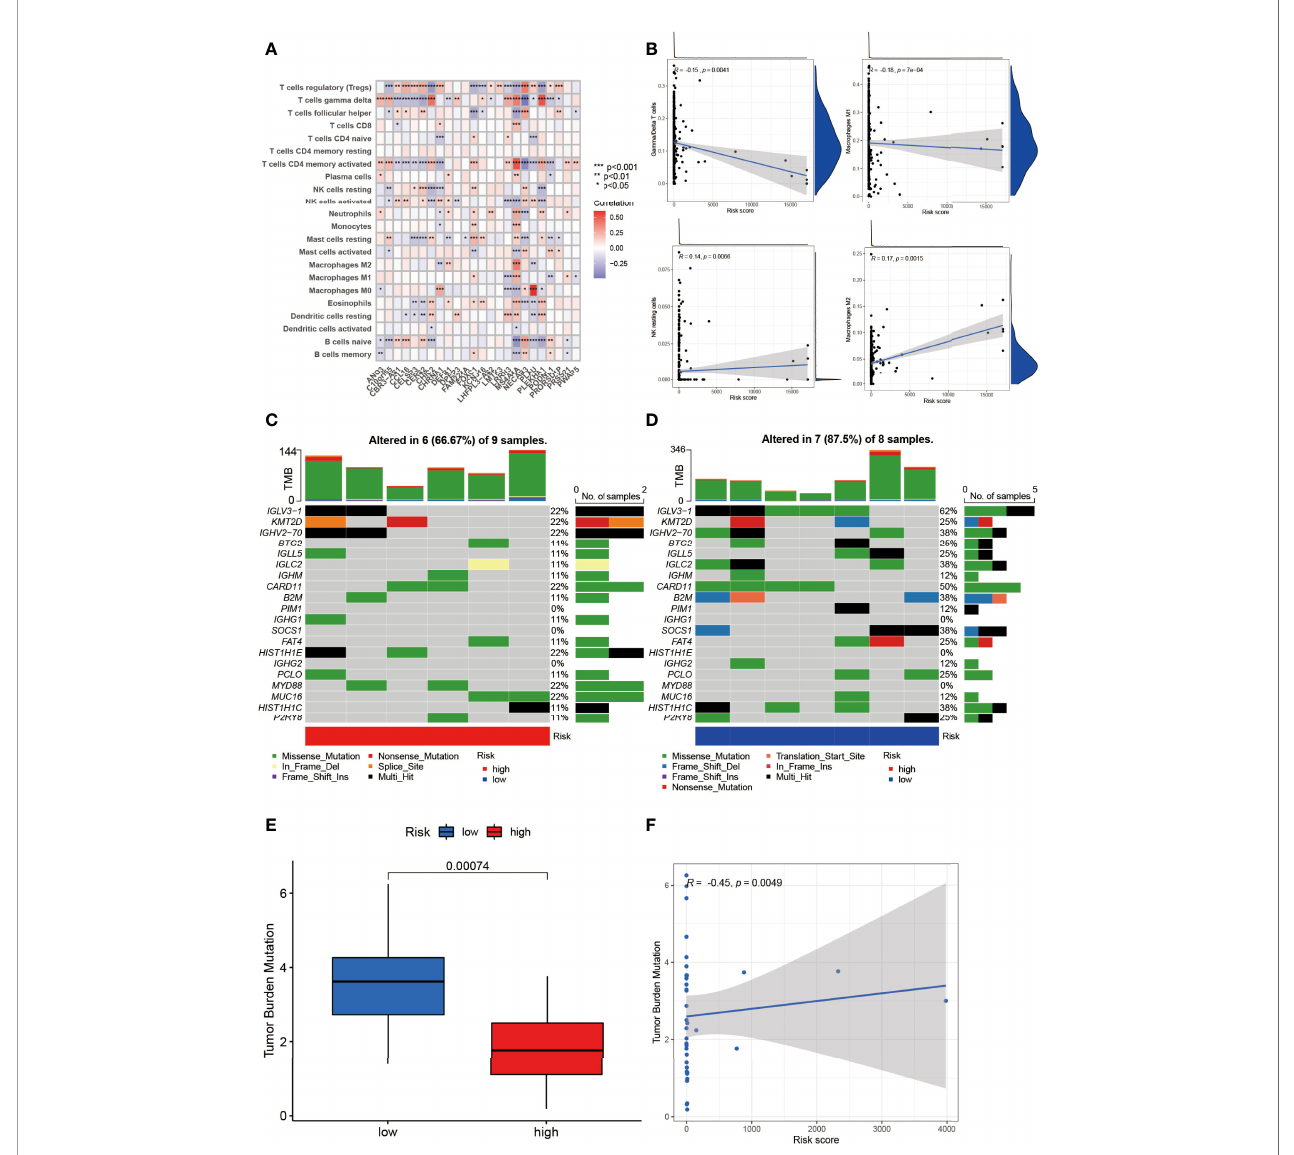
FIGURE 7 | Identi fi cation of immune in fi ltration and genetic variants underlying the different risk groups. (A) The correlation intensity between DEGs and immune cells. (B) The relationship of immune cells in risk score. g / d T cell and Macrophage 1 were negatively correlated with risk score while NK resting cell and Macrophage 2 were positively correlated ( p < 0.01). The CNV frequency of (C) high-risk and (D) low-risk groups. (E) The TMB between the low- and high-risk group ( p = 0.00074). (F) The correlation of TMB and risk score ( p = 0.0049). * p < 0.05, ** p < 0.01, *** p <